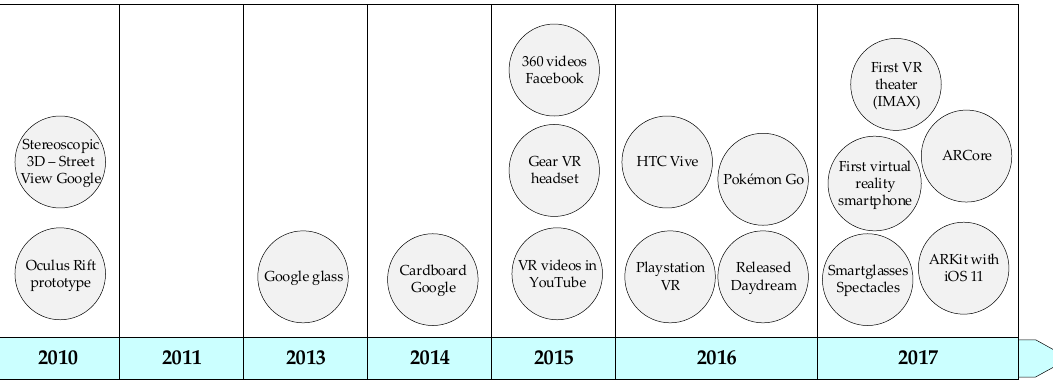
Figure 4. Evolution of virtual and augmented reality during the last decade. Adapted from [33].